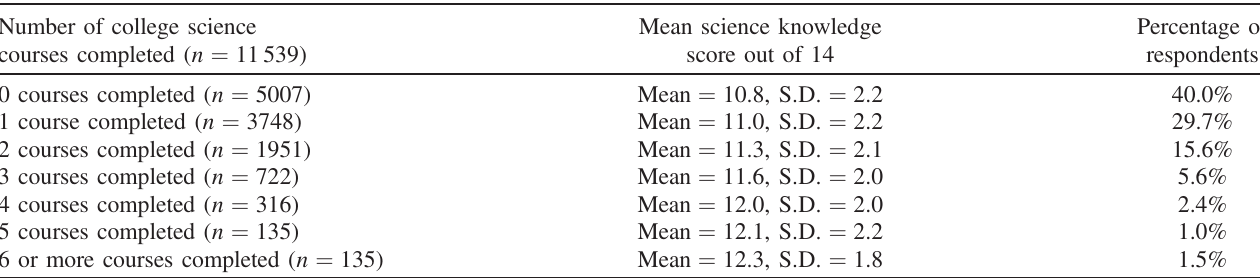
TABLE VIII. Average science knowledge score by number of college science courses completed.